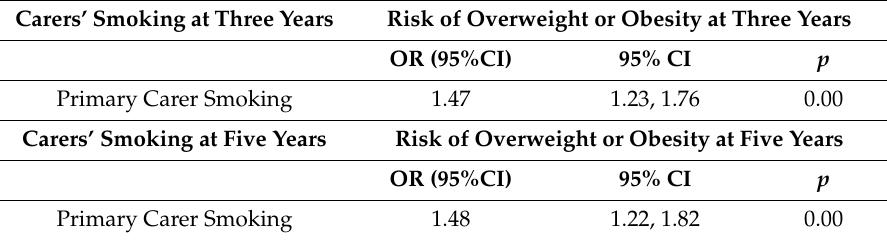
Table A3. Crude ORs (95% CI) for the impact of primary carers’ smoking at each wave with reference to non-smoking